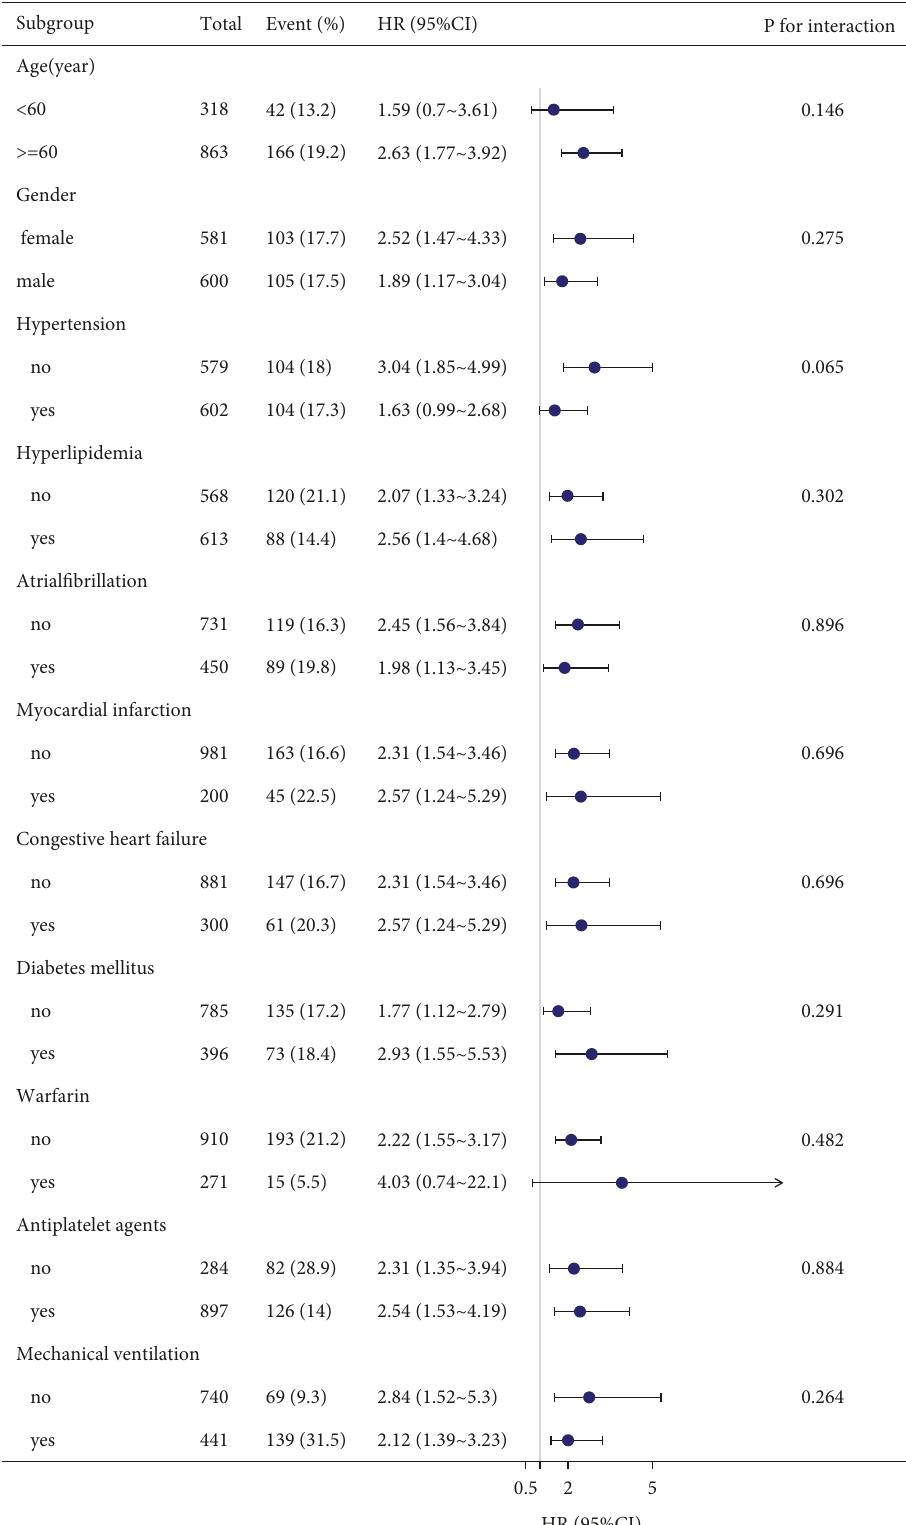
Figure 4: Subgroup analysis of the associations between SII and 30-day